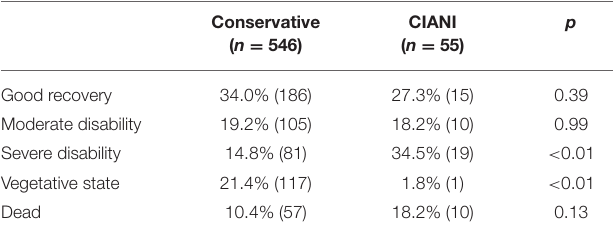
TABLE 4 | Glasgow outcome scale after 6 months.